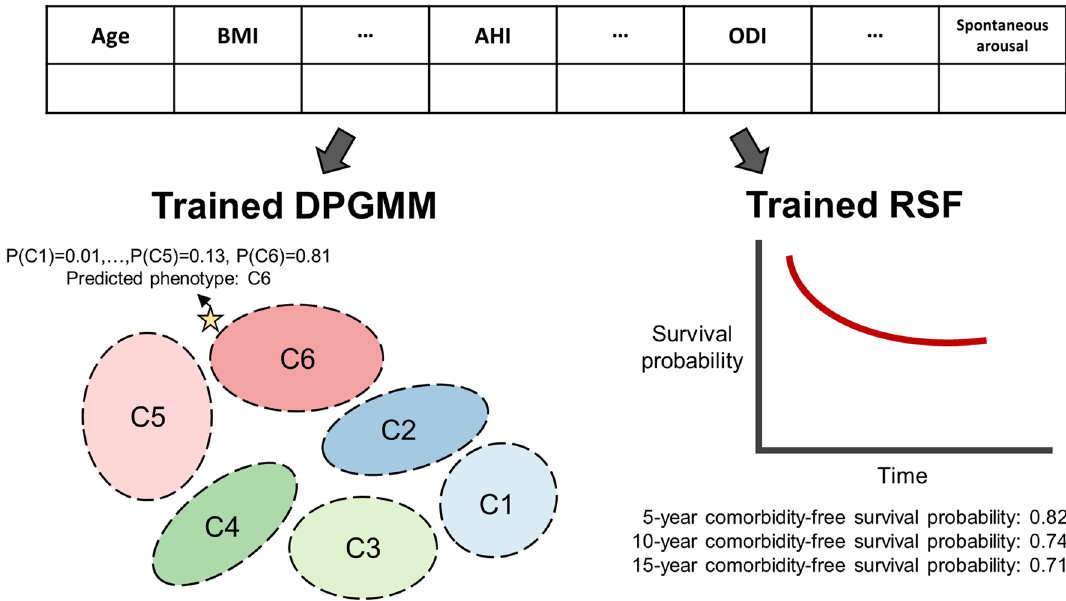
Figure 6. Phenotyping and survival prediction for new patients using the trained DPGMM and RSF. Our computational package calculates the cluster assignment probabilities for new patients based on their 43 PSG features (left) by using the trained DPGMM model in this study (Fig. 1b and Table 1). Furthermore, it predicts their comorbidity risks and the corresponding comorbidity-free survival curve (right) by using the trained RSF in this study (Fig. 1c and Fig.